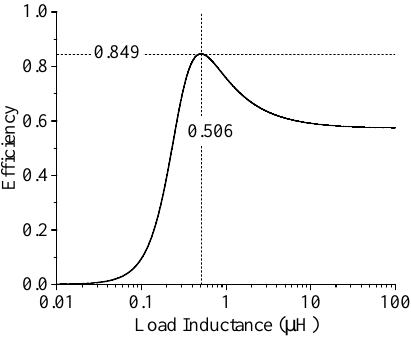
Figure 5. The simulated efficiency η as a function of varying shunt load inductance for the given system of three transmitters and a single receiver. The load inductance is varied, while keeping the other system parameters at their optimal